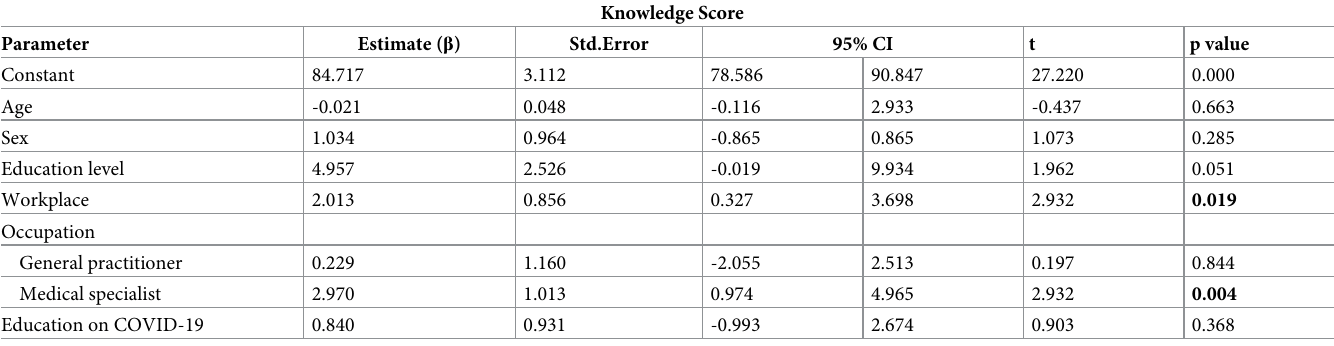
Table 4. Multiple regression analysis results of explanatory variables for knowledge scores.